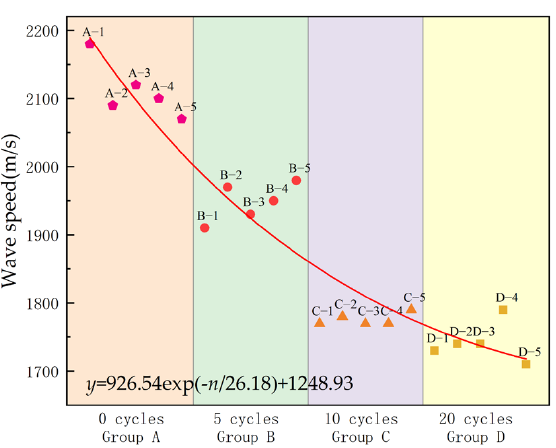
Figure 3. Wave velocity values of rock specimens of fracture–grouted rock with different groups of wetting–drying cycles.